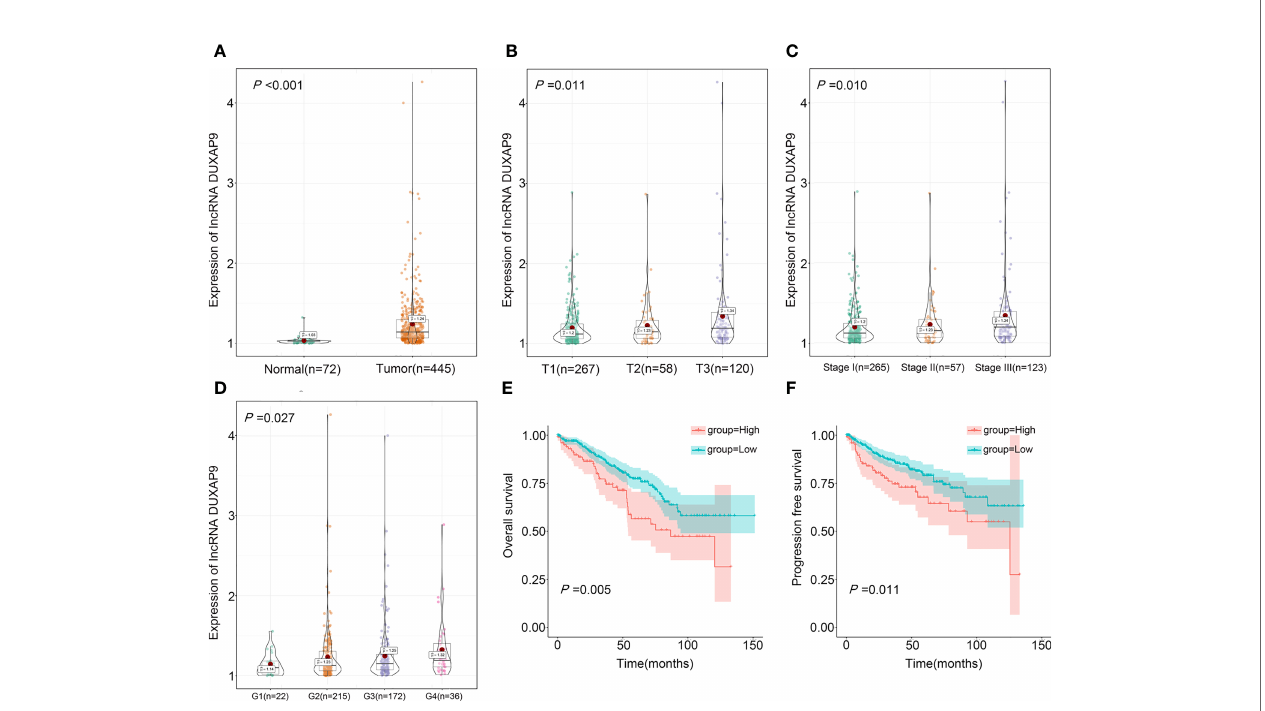
FIGURE 2 | DUXAP9 was identi fi ed as an oncogenic factor and predicted poor prognosis in localized ccRCC patients in the TCGA database. (A) DUXAP9 expression in 445 localized ccRCC tissues and 72 normal tissues in the TCGA database. (B – D) DUXAP9 expression increased with increasing T classi fi cation, stage, and Furman grade. (E, F) Kaplan – Meier analyses con fi rmed that high DUXAP9 expression (n=103) in localized ccRCC tissues was signi fi cantly associated with poor OS and PFS, compared with low expression (n=342). ccRCC, clear cell renal cell carcinoma; TCGA, The Cancer Genome Atlas; OS, overall survival; PFS, progression-free